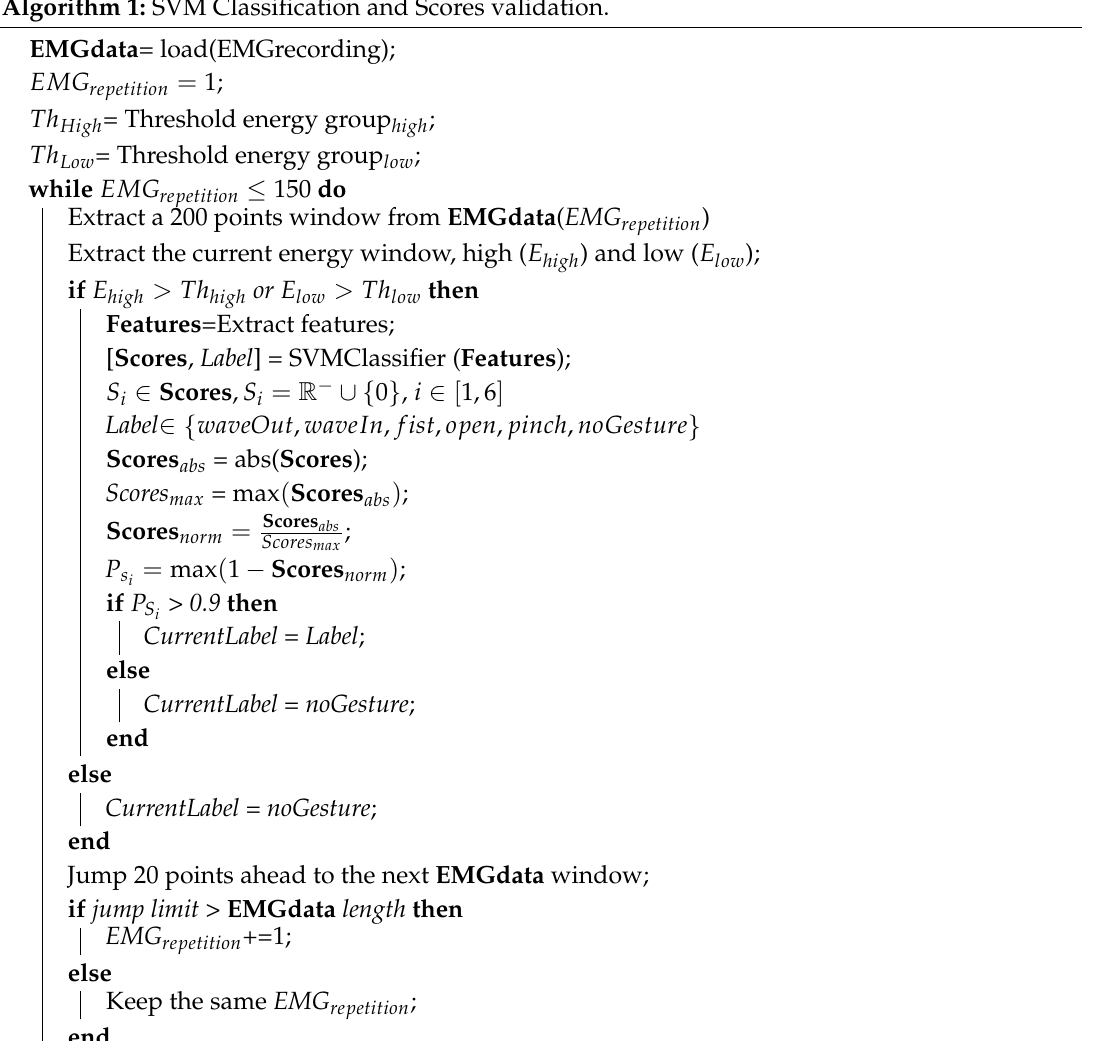
Algorithm 1: SVM Classification and Scores